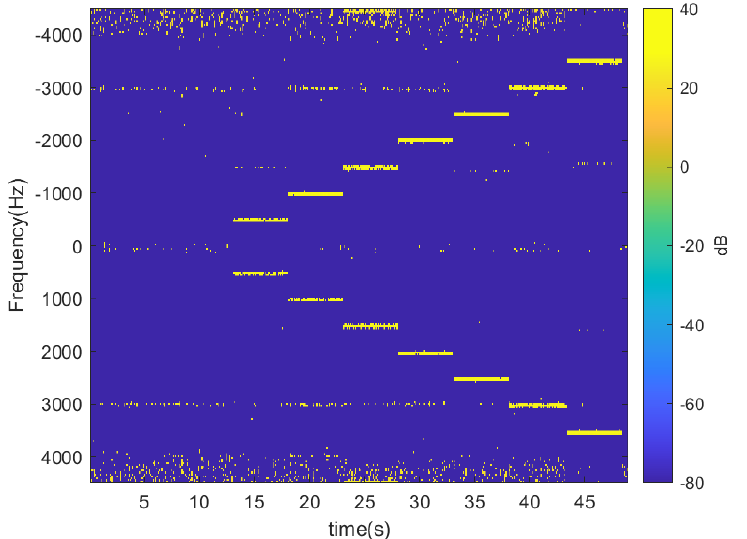
Figure 15. Spectrogram for different modulation frequencies with the immobilized tag located in front of the radar at 2 m after applying the CFAR